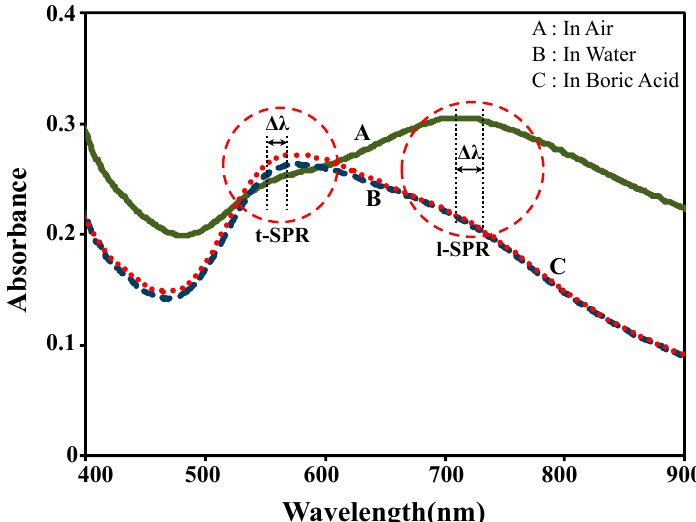
Figure 2. The spectra of Au nanoplates in three different mediums: ( A ) air, ( B ) deionized (DI) water, and ( C ) 1 mM boric acid.